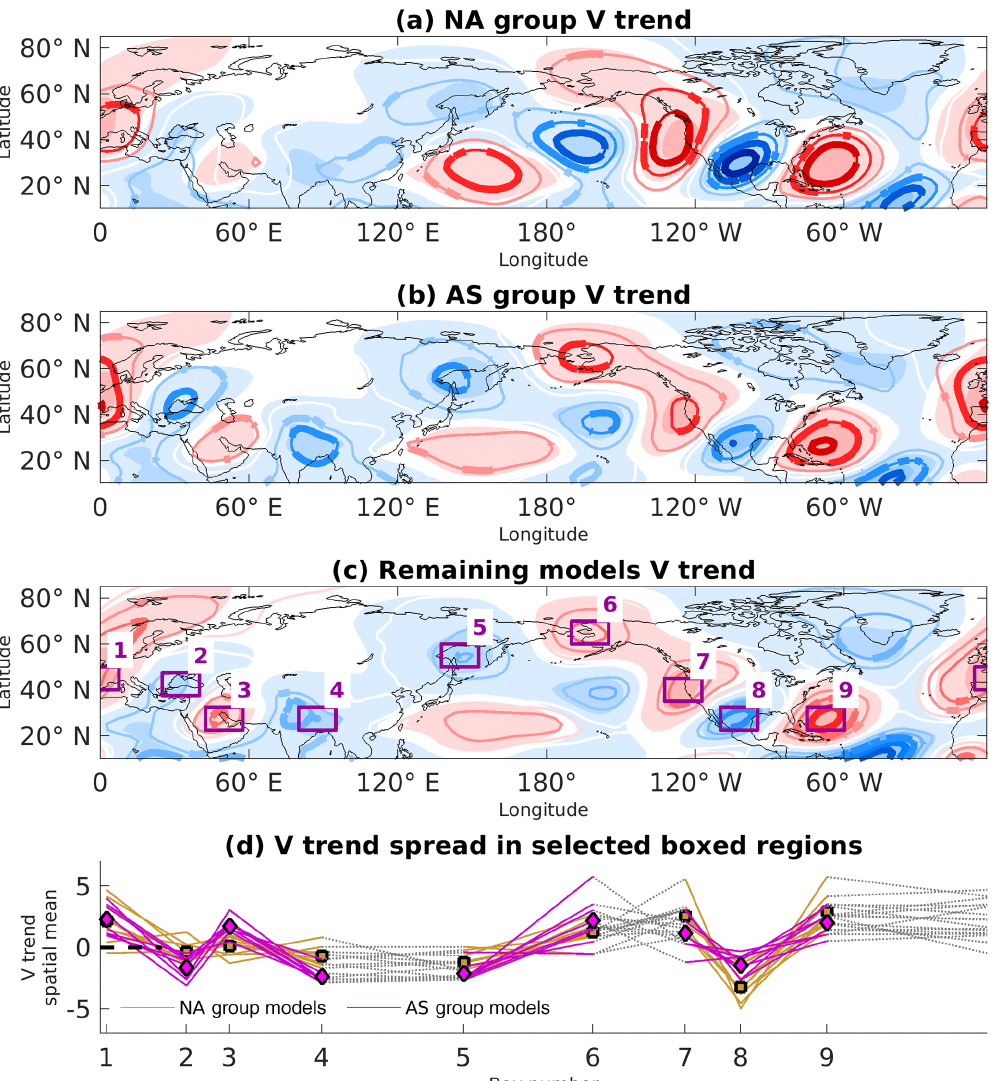
Figure 8. The future–past 300hPa DJF V climate trend for all models in the NA (a) , AS (b) , and “none” groups (9, 8, and 17 models, respectively). The two models with preferred phasing in both regions (“both” group) were added to the (a) and (b) composites. The contour interval is 1ms − 1 , and the bold contours signify areas where over 90% of group members share the same sign with the composite. In shading, the MMM V trend is as in Fig. 4a. (d) The spatially averaged V trend (ms − 1 ) in the nine boxed regions in (c) , for every model in the NA and AS groups (orange and magenta, respectively). Square (diamond) markers denote the NA (AS) group mean for every box. Some lines are partially grayed out to better indicate separate geographical